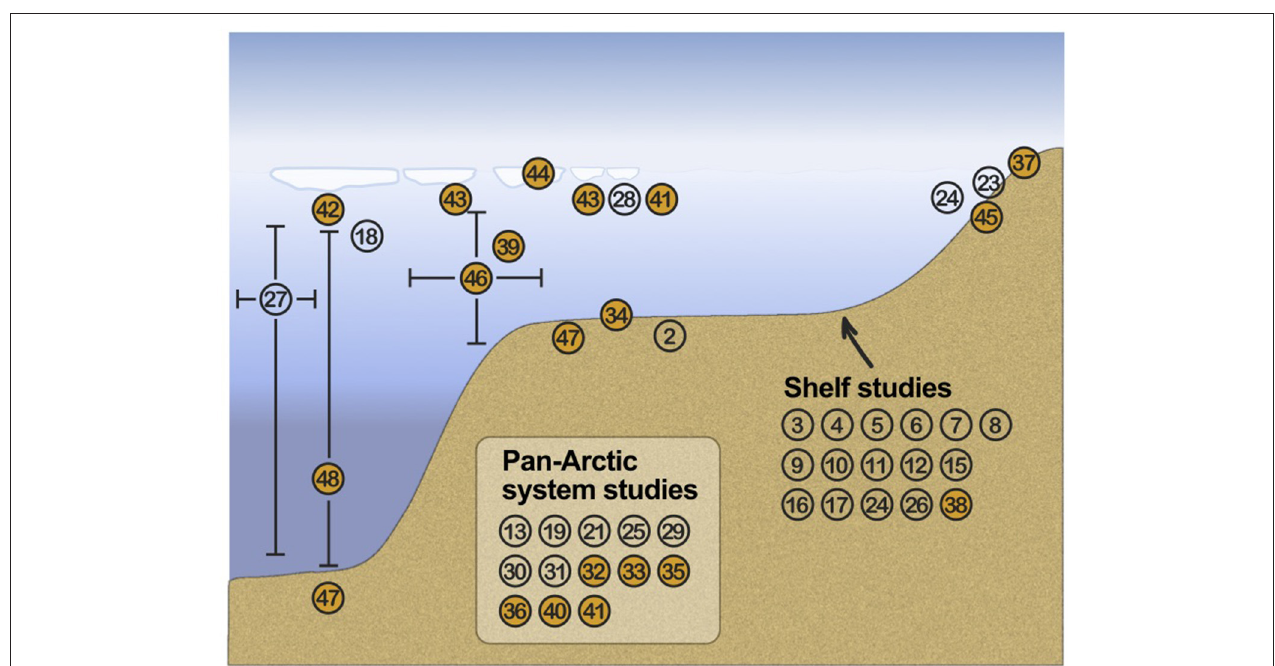
FIGURE 2 | An idealized cross section of the Arctic Ocean shelf and the distribution of publications that deal with particular ecosystem processes. The insert shows the publications dealing with processes investigated throughout the pan-Arctic Ocean expanse. The geographic shelf studies, presented in Figure 1 were excluded. The colored circles indicate the publications from the present